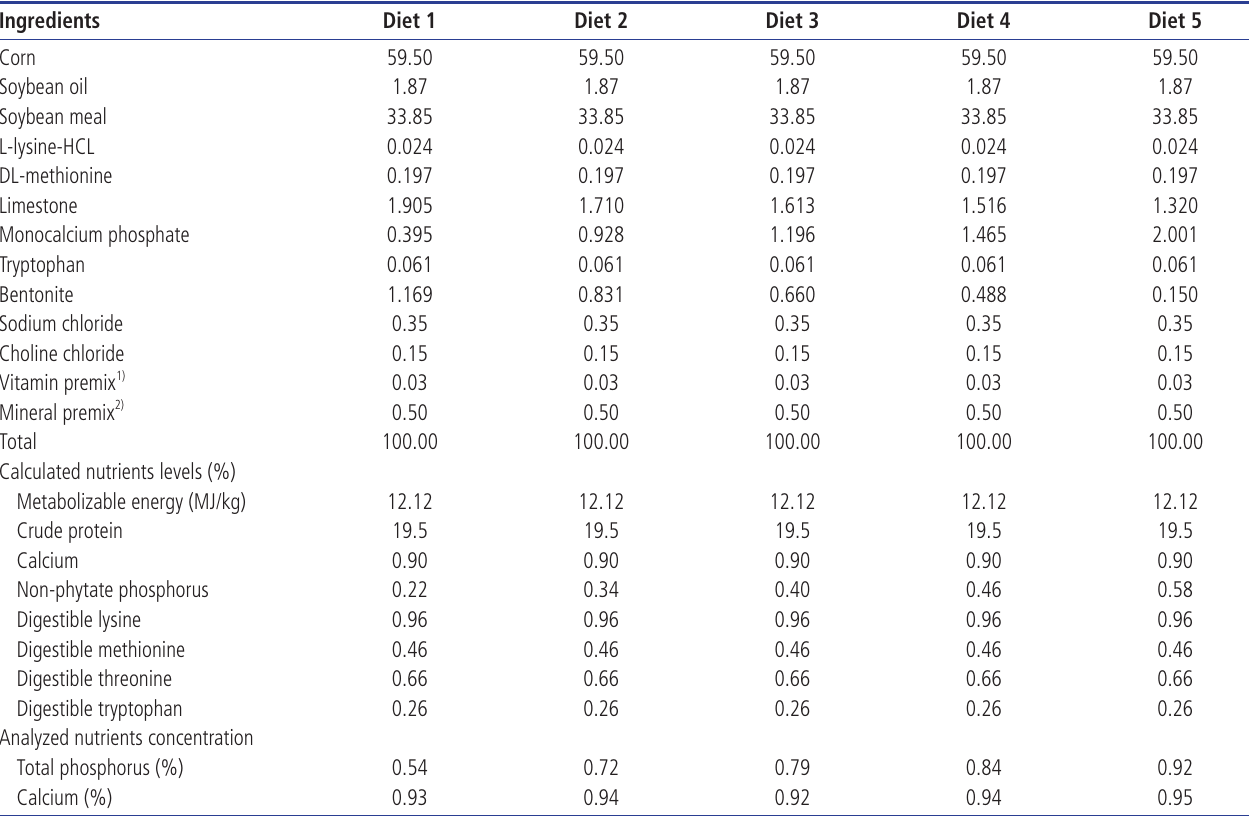
Table 1. Ingredients and compositions of the experimental diets (%, dry matter basis)